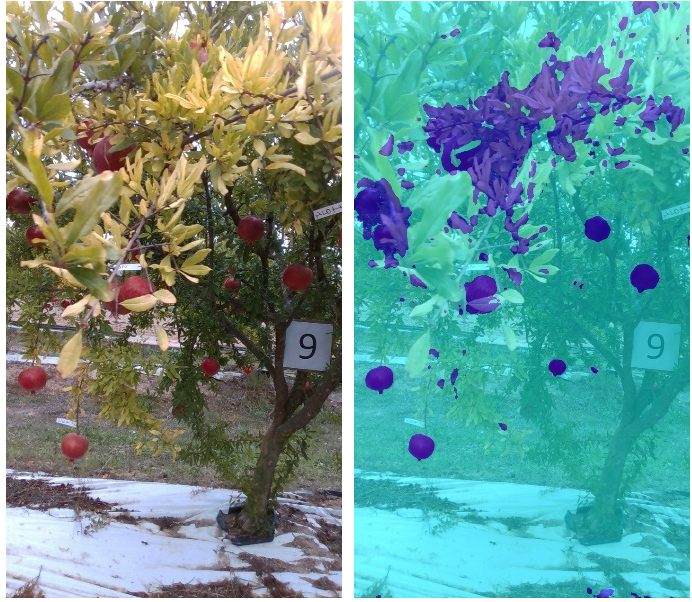
Figure 9. Final CE net result for a sample image acquired in the field. ( Left ): original image; ( right ): segmentation result.